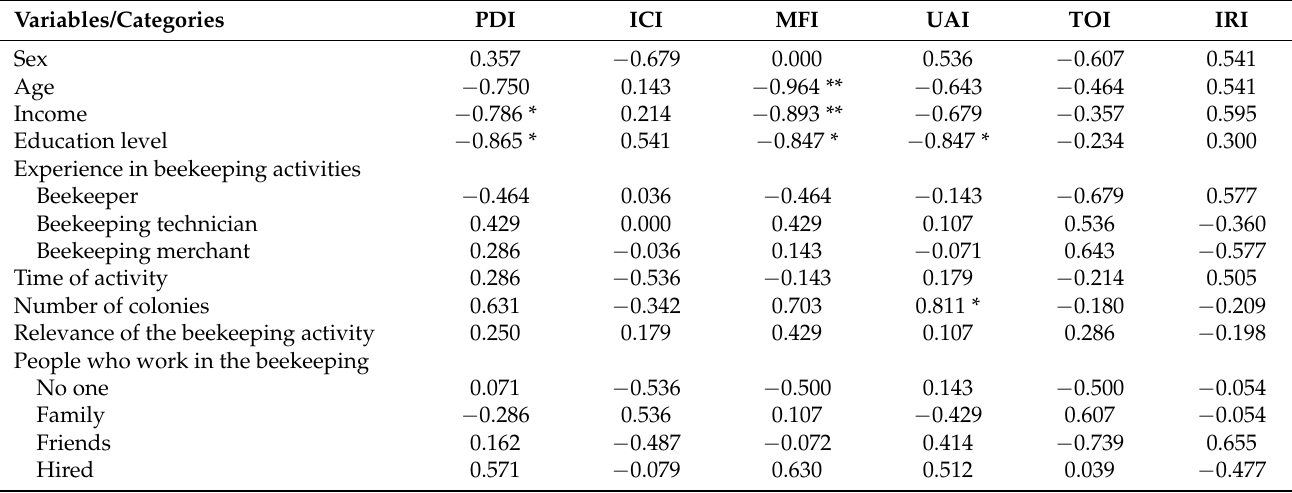
Table 5. Spearman correlations between the Hofstede scores of cultural dimensions and the variables that characterize beekeeping activities and the sociodemographic characteristics of